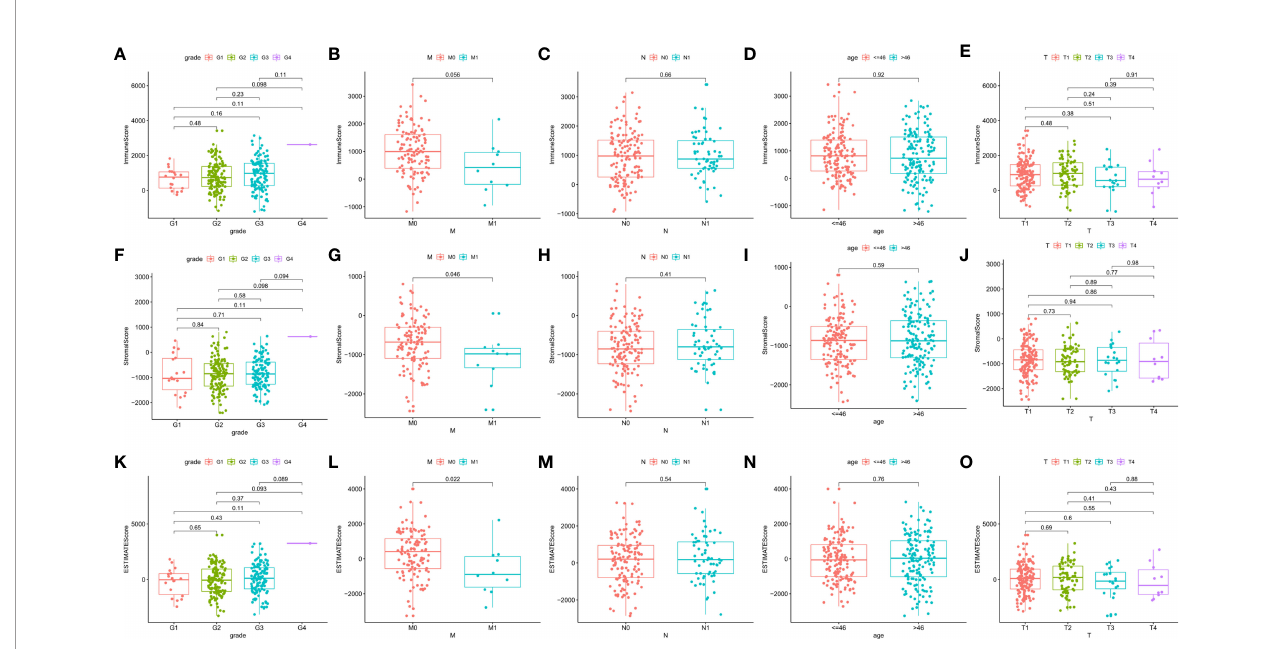
FIGURE 3 | Correlation of ImmuneScore and StromalScore with clinicopathological staging characteristics. (A – E) Distribution of ImmuneScore in grade, M, N, age, and T classi fi cation. The p value is calculated by Kruskal – Wallis rank sum test. (F – J) Distribution of StromalScore in grade, M, N, age, and T classi fi cation. The p value is calculated by Kruskal – Wallis rank sum test. (K – O) Distribution of ESTIMATEScore in grade, M, N, age, and T classi fi cation. The p value is calculated by Kruskal – Wallis rank sum test.